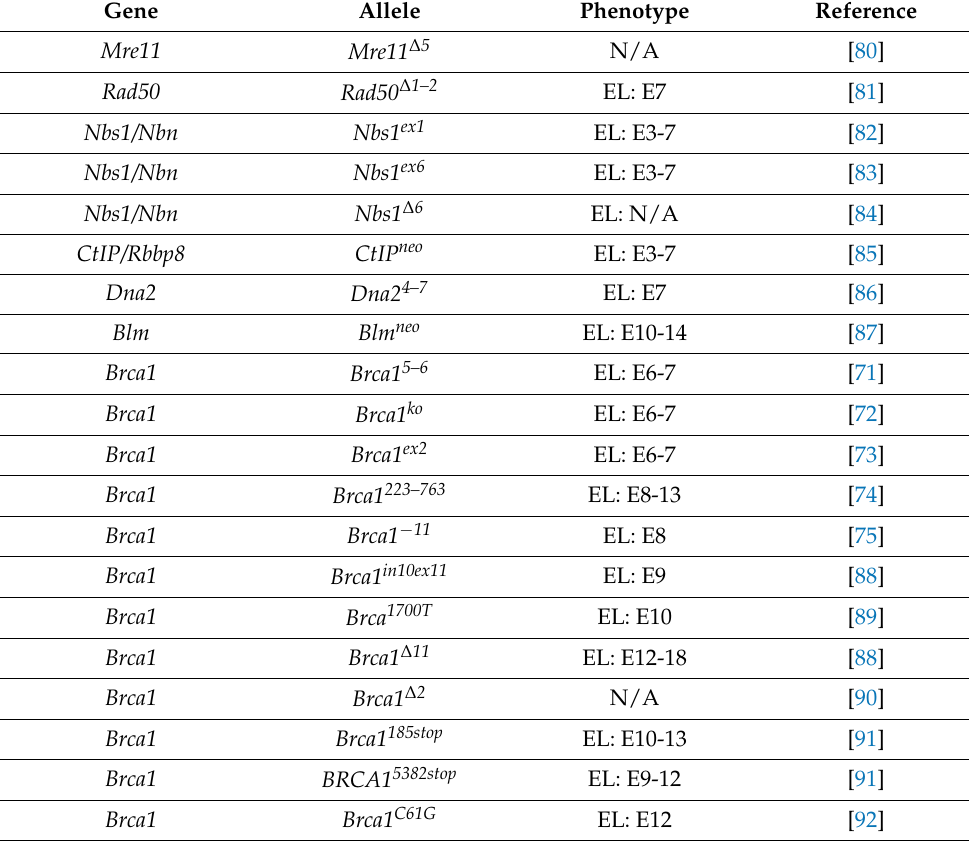
Table 1. Embryonic lethal mouse models of complete or severe loss of function of HR genes. Phe- notype: when the mutant allele is in homozygosis. EL: embryonic lethal. N/A: not available. “Enumber”: day of embryonic development